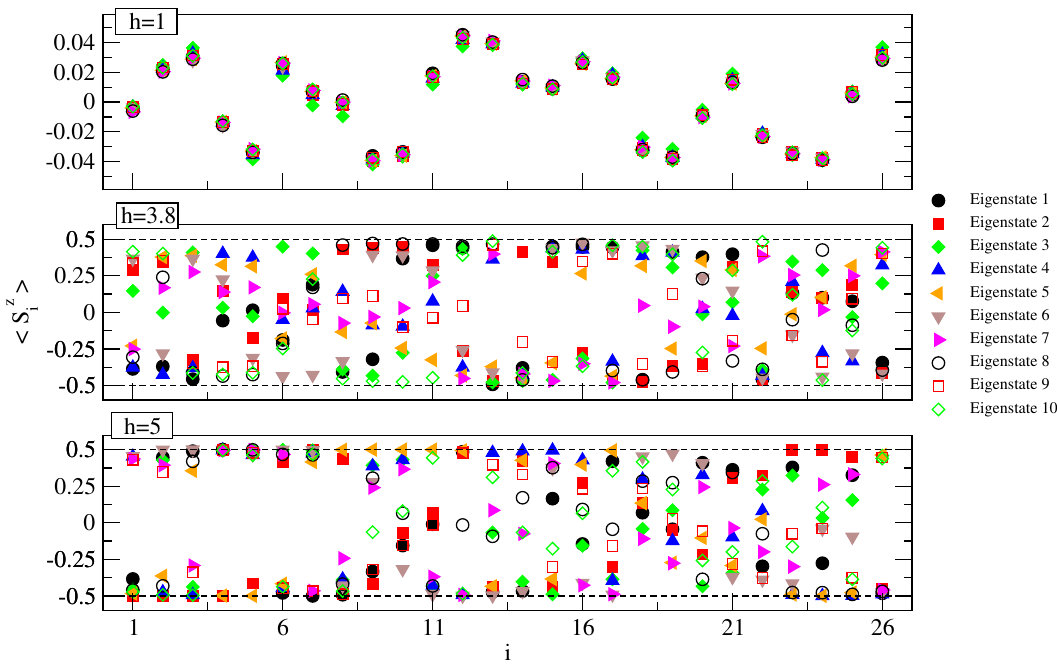
〉 as a function of site index i for a L = 26 chain for 10 eigenstates at Figure 10: 〈 S z i ε = 0.5 with different values of disorder: h = 1 (top panel) in the ETH phase, h = 5 (bottom) in the MBL phase, and h = 3.8 (middle panel) close to the critical